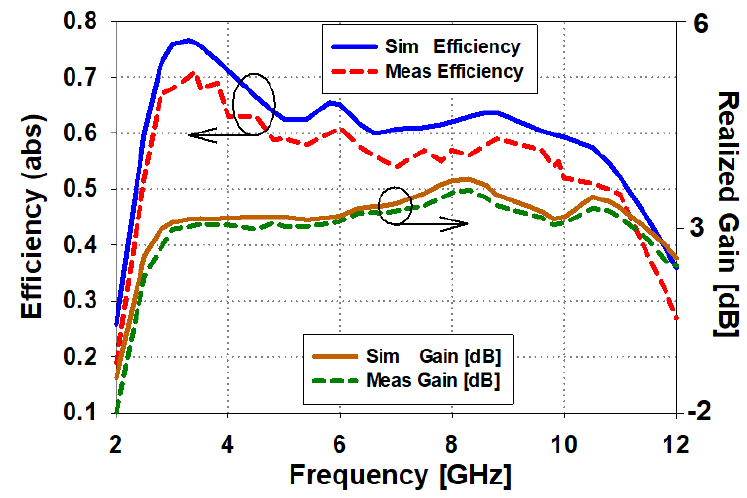
Figure 9. Comparison of simulated and measured efficiency and peak gains (dB).